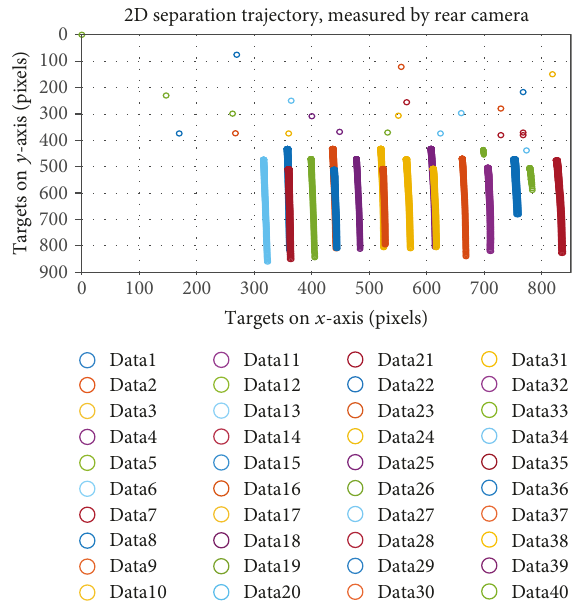
Figure 29: 2D separation trajectory measured by the rear camera.